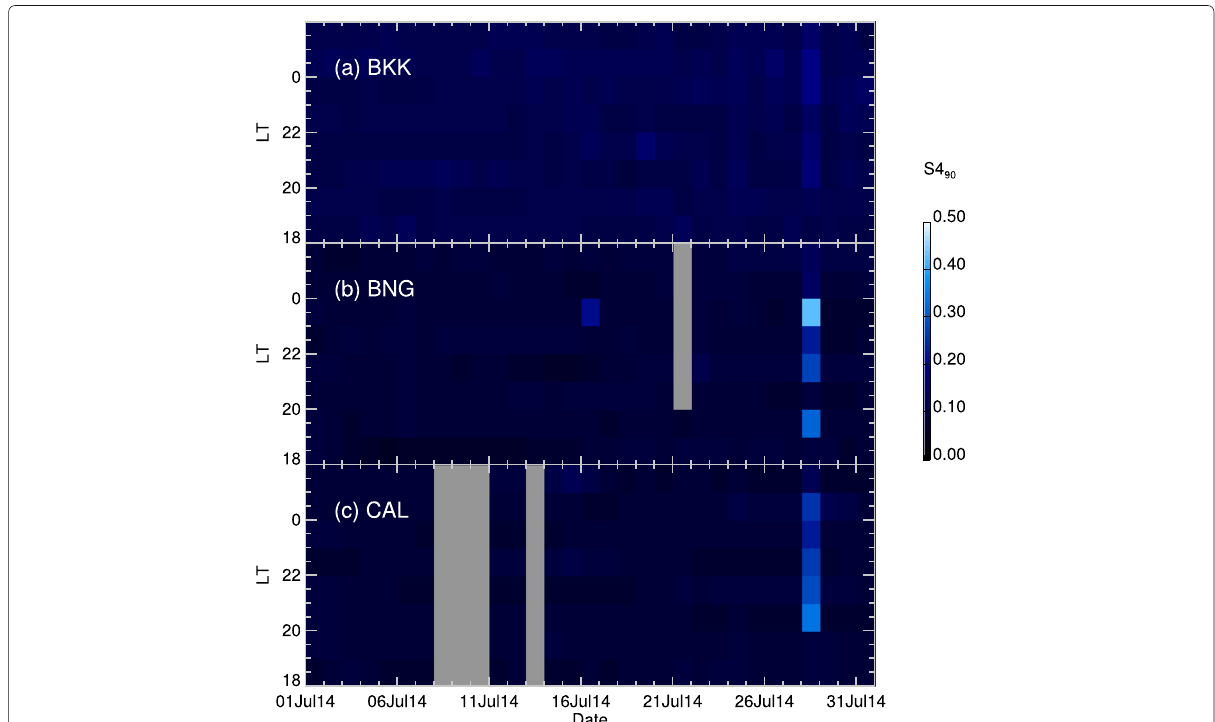
Fig. 1 The 90th percentile of the hourly S4 index S 90 as a function of local time and date throughout July 2014, as detected by a BKK, b BNG, and c CAL GPS stations. Gray cells indicate data